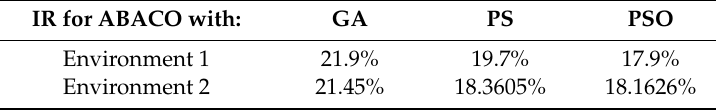
Table 8. Improvement ratio (IR) of the ABACO and algorithms in Reference [31].